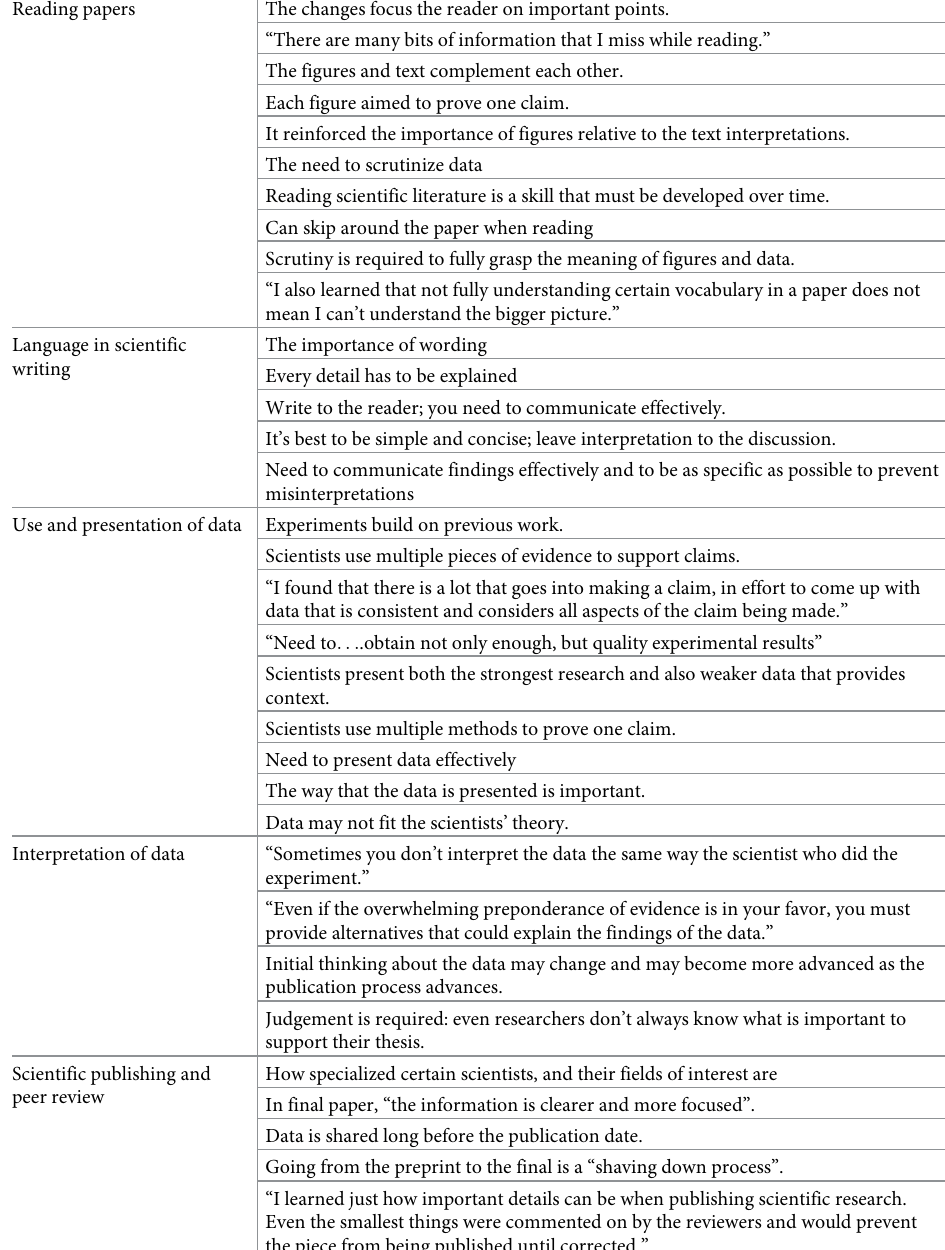
Table 2. Results of student reflections on the preprint analysis